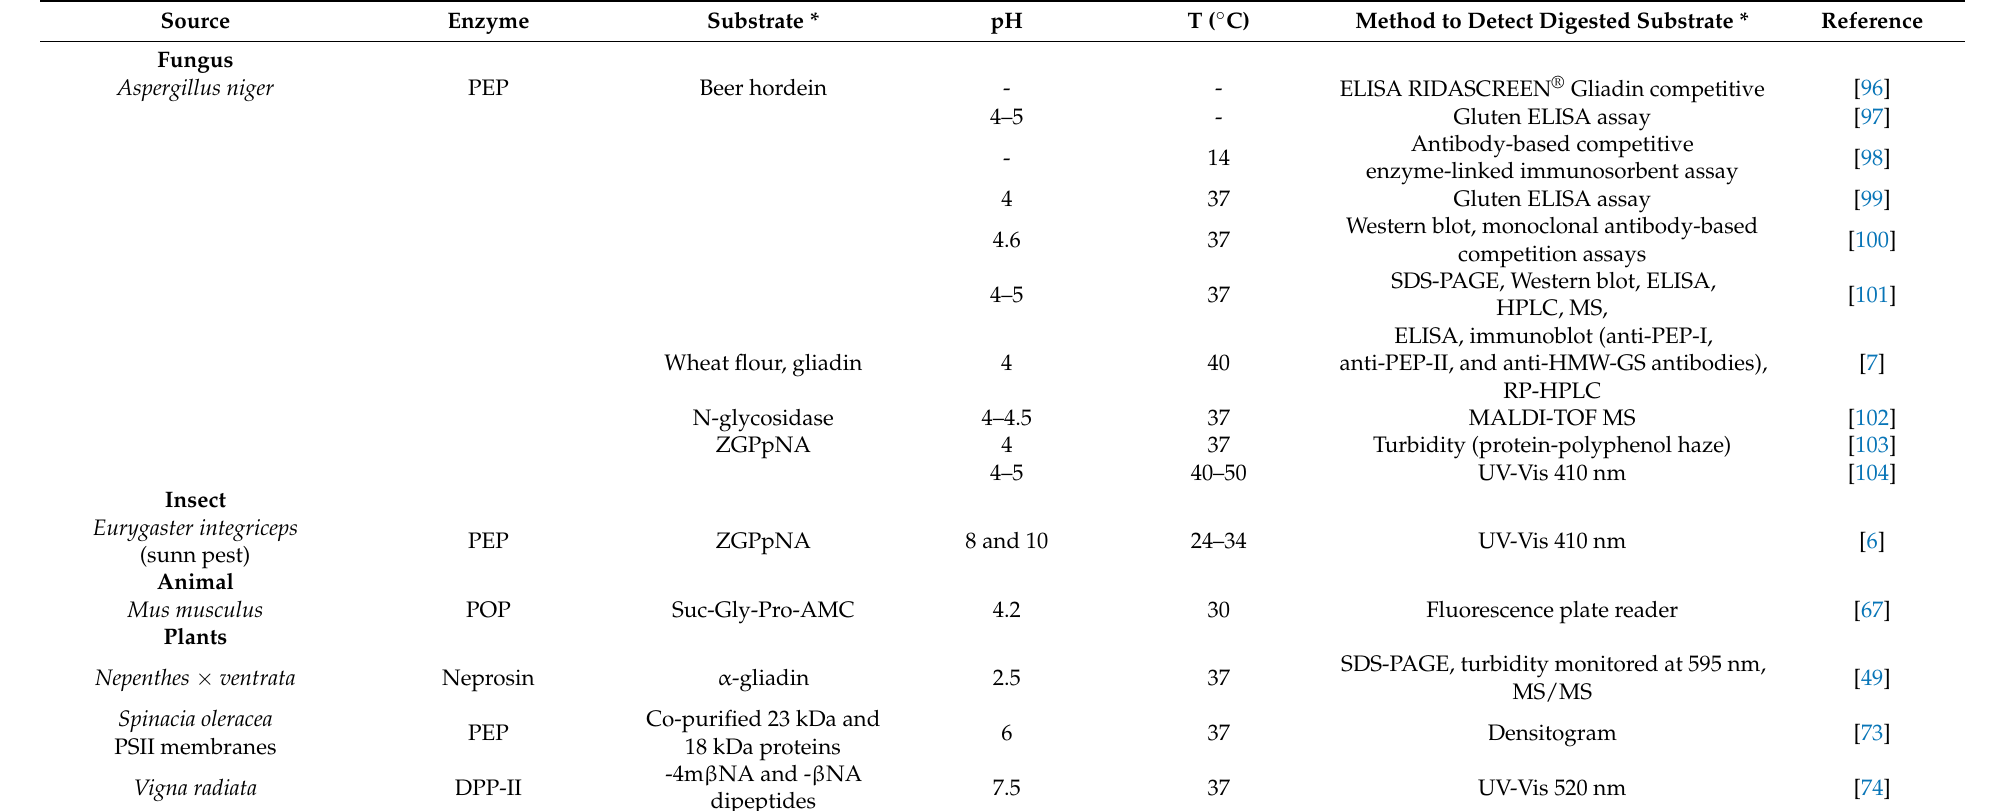
Table 3. The optimum conditions of selected native PPCEs in substrate